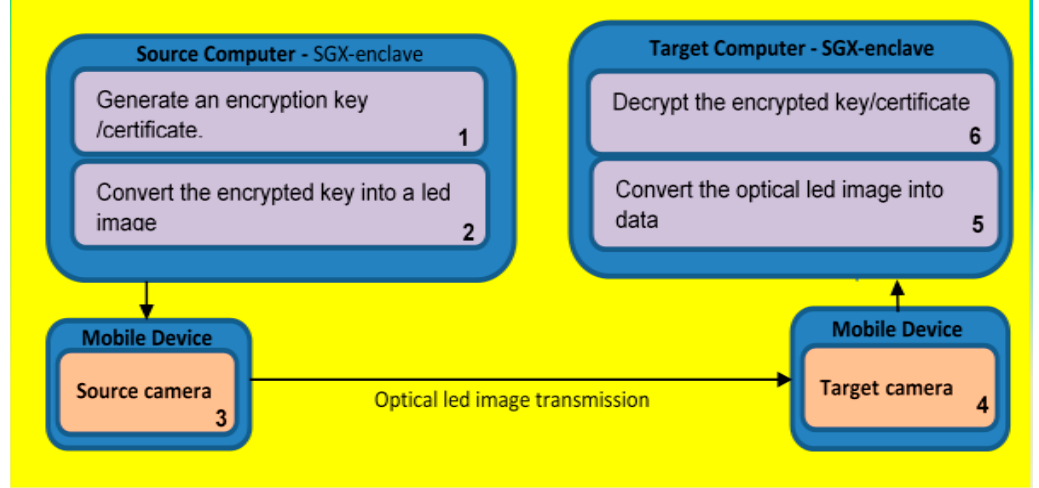
Figure 6. Encryption key generation and optical-based transmission flow.